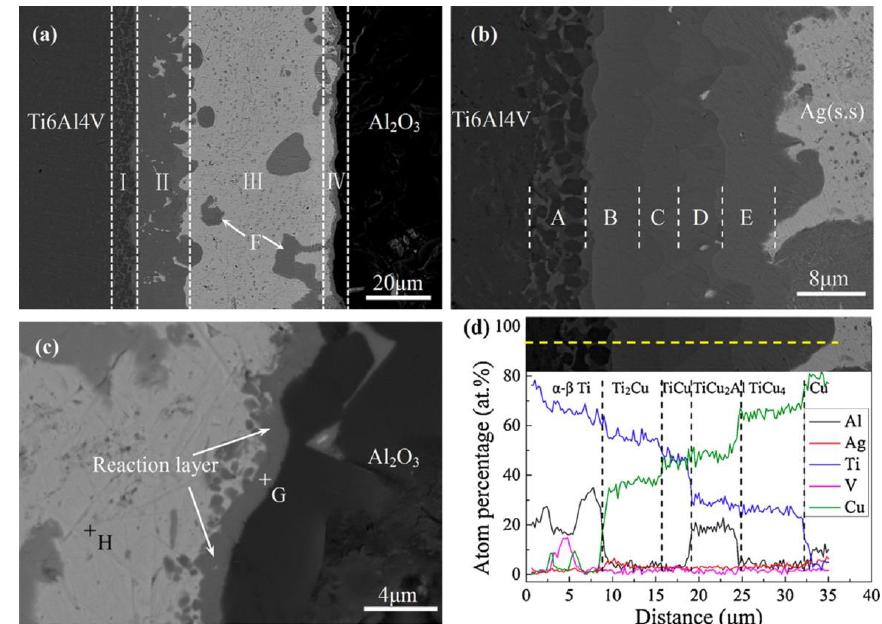
Figure 4. Microstructure of Ti6Al4V/Al 2 O 3 joint brazed with Ag-Cu filler metal at 880 °C for 10 min: ( a ) The whole joint; ( b ) magnification of Ti6Al4V/filler interface; ( c ) magnification of filler/Al 2 O 3 interface; ( d ) elemental energy-dispersive X-ray spectroscopy (EDS) line profiles across regions I and II, reproduced from Reference [26] with permission of Elsevier, 2016.